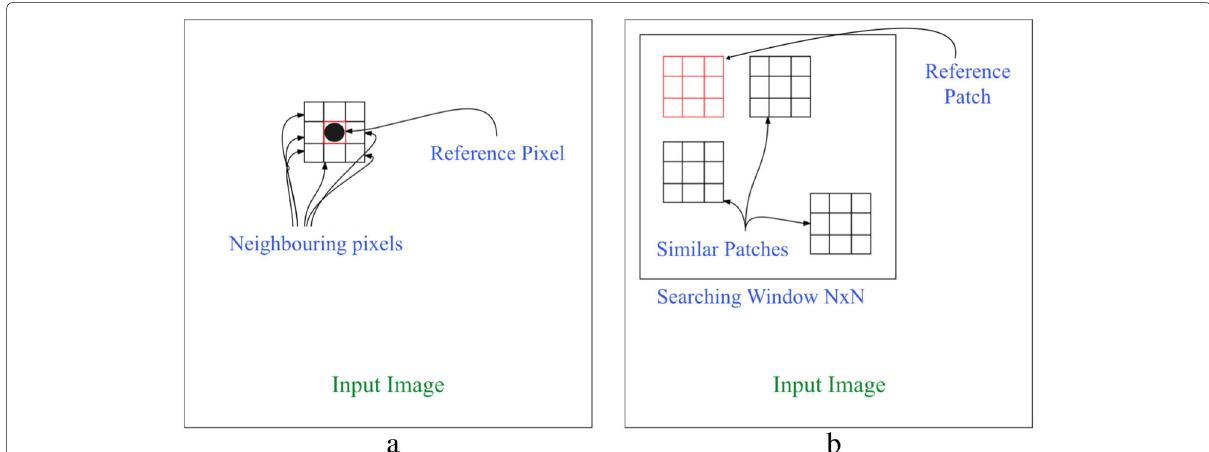
Fig. 1 Image denoising approaches: a filtering based on neighboring pixels located within a kernel in pixel-based denoising schemes and b filtering based on patches located within a search window in patch-based denoising schemes